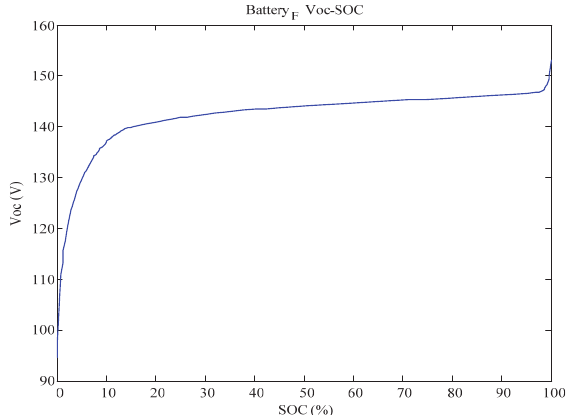
Figure 3. The open circuit voltage and state of charge curve of the front battery pack.